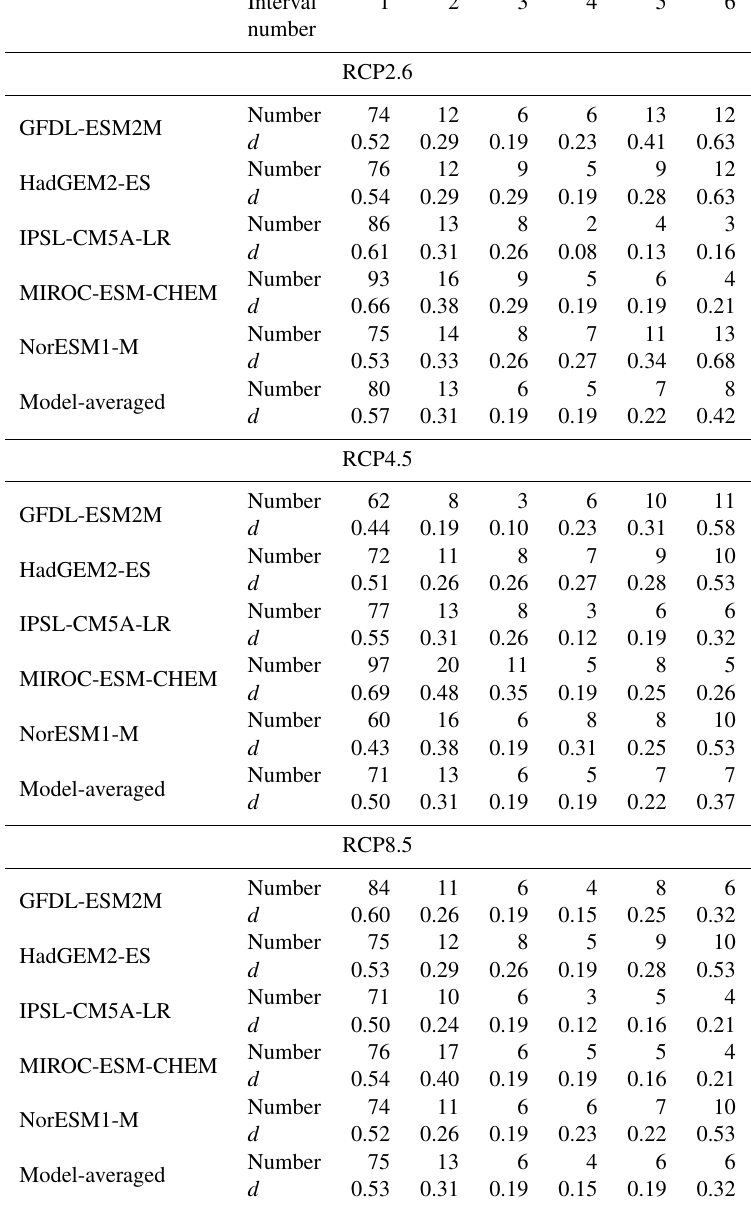
Table 3. Numbers of catchments with (cid:49)Q e > 0 and respective d in each interval based on Q of five GCMs and their means in the analysis of the projected trends under three scenarios. Interval numbers based on Q and ϕ are consistent with those in Table 1, as are the interval range and the sample size of each interval. d is the proportion of catchments becoming wetter in each